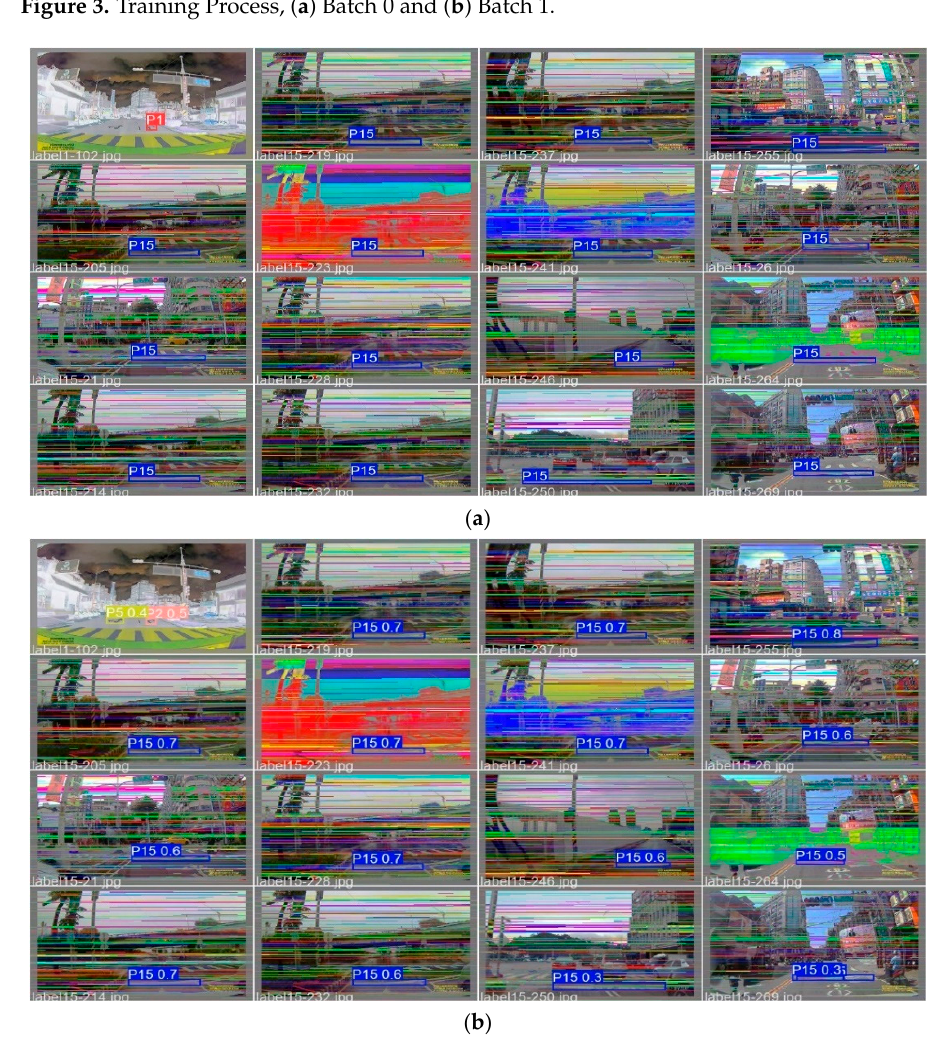
Figure 4. Validation Process batch 0. ( a ) Labels and ( b ) Predictions.